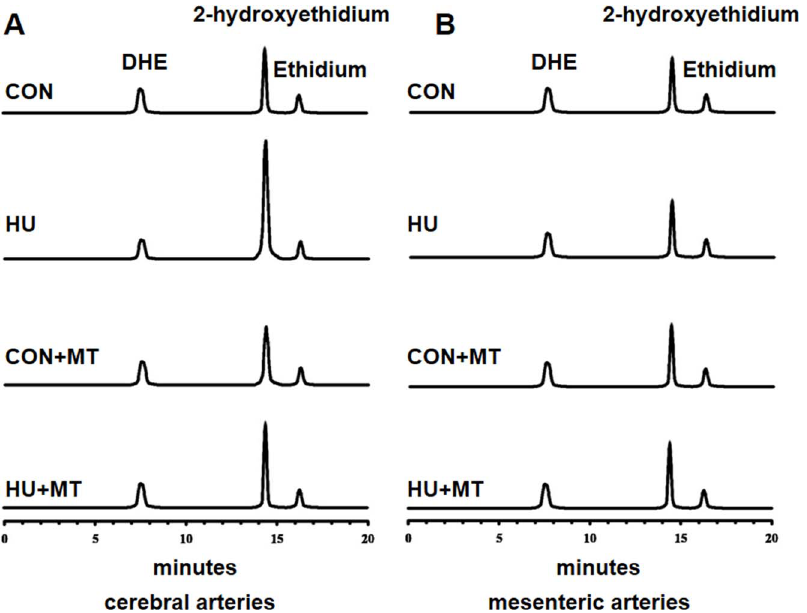
Figure 1. HPLC analysis of DHE-derived products in rat cerebral (A) and mesenteric (B) vascular smooth muscle cells. The cerebral and mesenteric vascular smooth muscle cells were stained with DHE. Ethidium, dihydroethidium and 2-hydroxyethidium were separated by HPLC-based method. CON, control; HU, hindlimb unweighting; CON + MT, mitoTEMPO-treated control; HU + MT, mitoTEMPO-treated HU; DHE, dihydroethidium; HPLC, high-performance liquid chromatography.